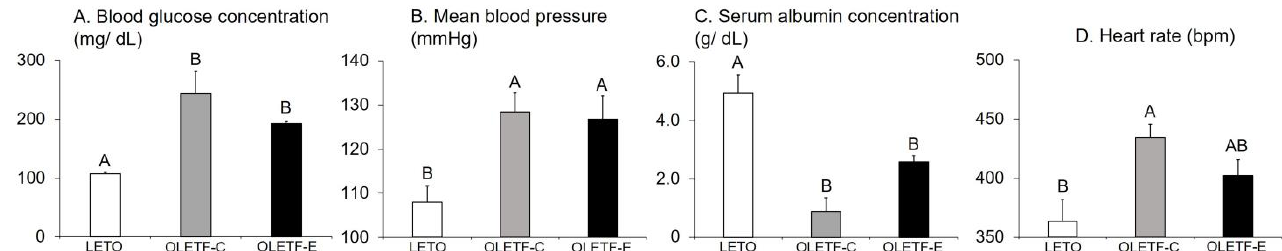
Figure 2. Blood glucose concentration ( A ) and serum albumin concentration ( C ) 16 weeks after the start of this study. Blood glucose levels were measured 6 h after eating. Mean blood pressure ( B ) and heart rate ( D ) 15 weeks after the start of this study. n = 5 per group. The bars represent mean values, and the error bars represent SE. Significant differences were determined using the one-way ANOVA, followed by multiple comparisons using Tukey’s post-hoc test. The letters represent significant differences between groups ( p < 0.05, Tukey’s post-hoc test).